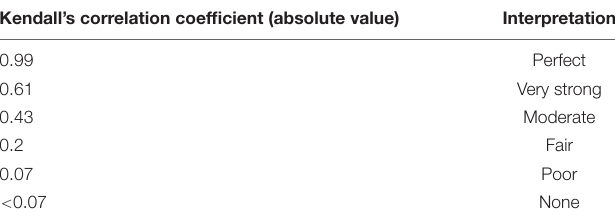
TABLE 1 | Interpretation of thresholds for Kendall’s correlation coefficients for this study (Gilpin, 1993; Chan, 2003; Akoglu, 2018). Kendall’s correlation coefficient (absolute value)